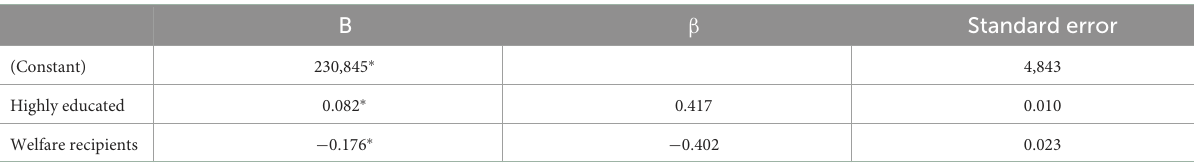
TABLE 2 Regression output for GPA